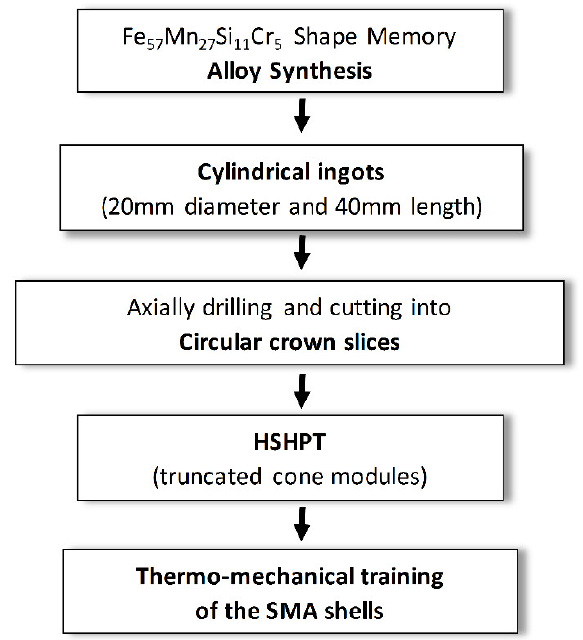
Figure 1. Schematic diagram of the experiment.